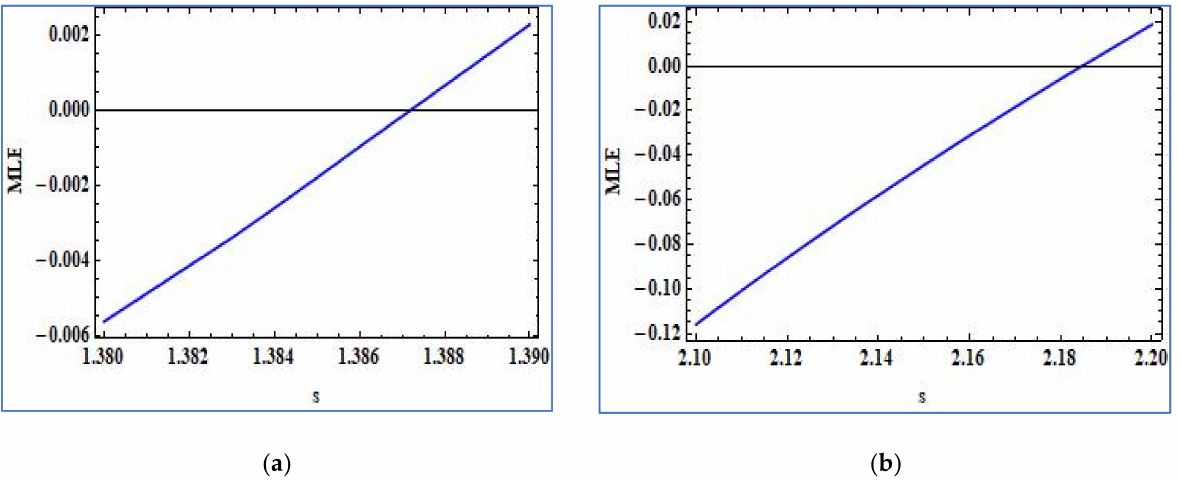
Figure 5. ( a ) Local implication for the Neimark-Sacker bifurcation and ( b ) local implication for period-doubling